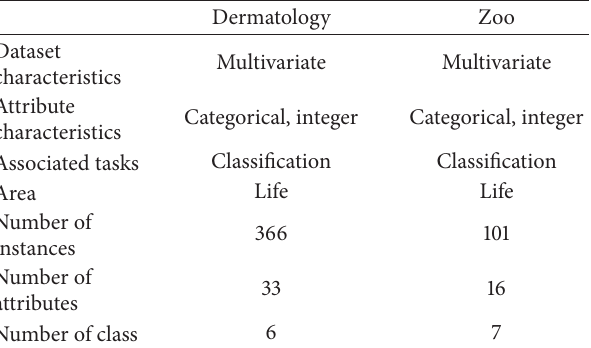
Table 1: Feature information for Dermatology and Zoo databases. Table 2: Attributes of Dermatology